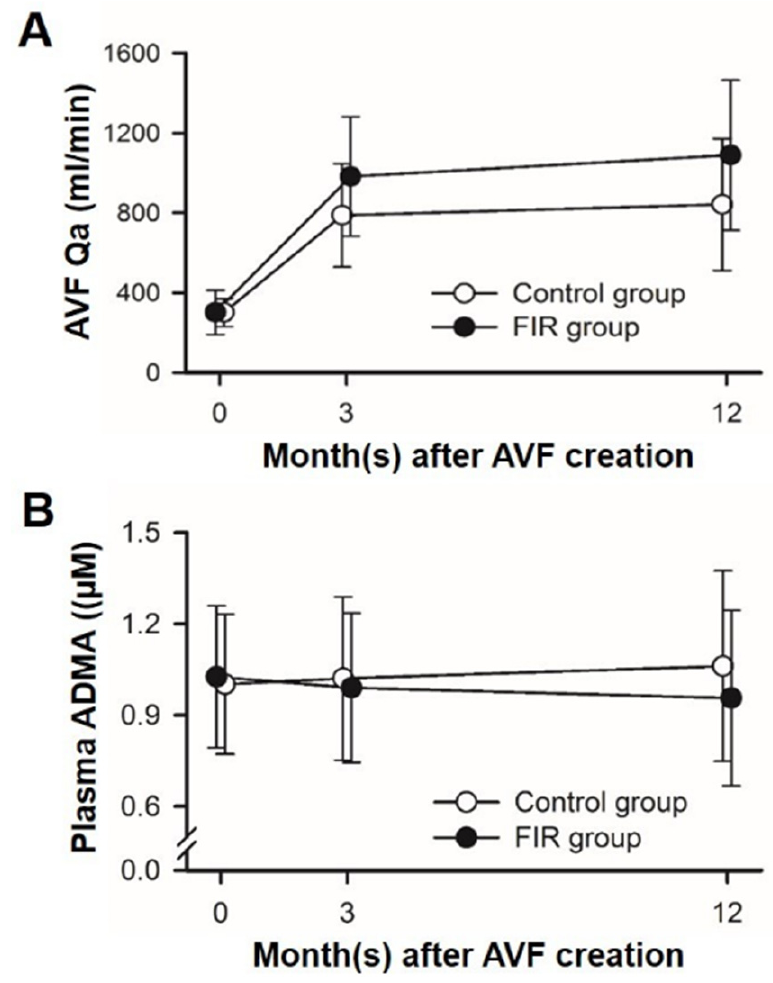
Figure 2. ( A ) AVF Qa on the 2nd day (labeled as 0), 3rd month, and 12th month after AVF creation; ( B ) Plasma ADMA concentrations on the 2nd day (labeled as 0), 3rd month, and 12th month after AVF creation. In comparison with the control group (white circles), AVF Qa in FIR group (black circles) are similarly distributed at most given concentrations of plasma ADMA before FIR therapy, but are relatively higher on the 3rd month as well as on the 12th month. Abbreviations: ADMA, asymmetric dimethylarginine; AVF, arteriovenous fistula; Qa, access blood flow; FIR, far-infrared. Table 2. Comparison of plasma ADMA concentrations and Qa, AVF maturation, and patency in advanced DKD patients with and without FIR therapy for 12